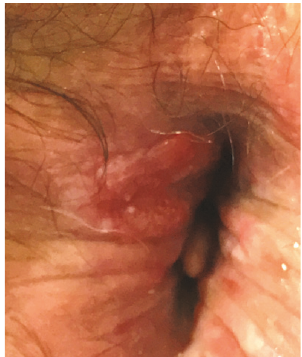
Figure 1: Clinical aspect of the lesion of the anal margin.